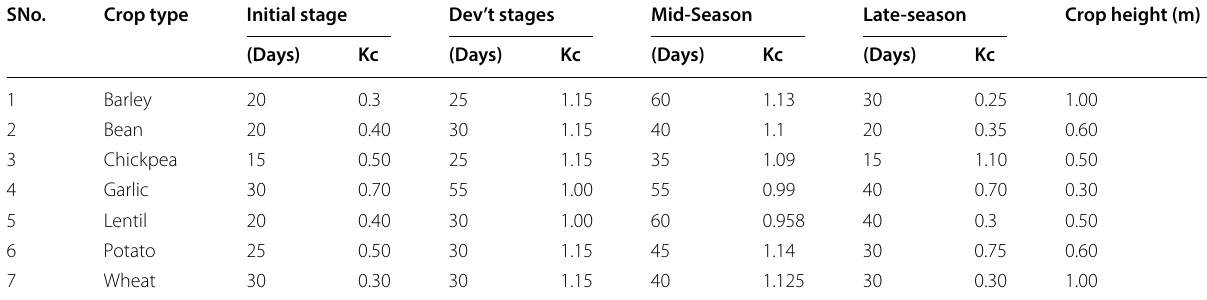
Table 2 Crop characteristics data for model inputs